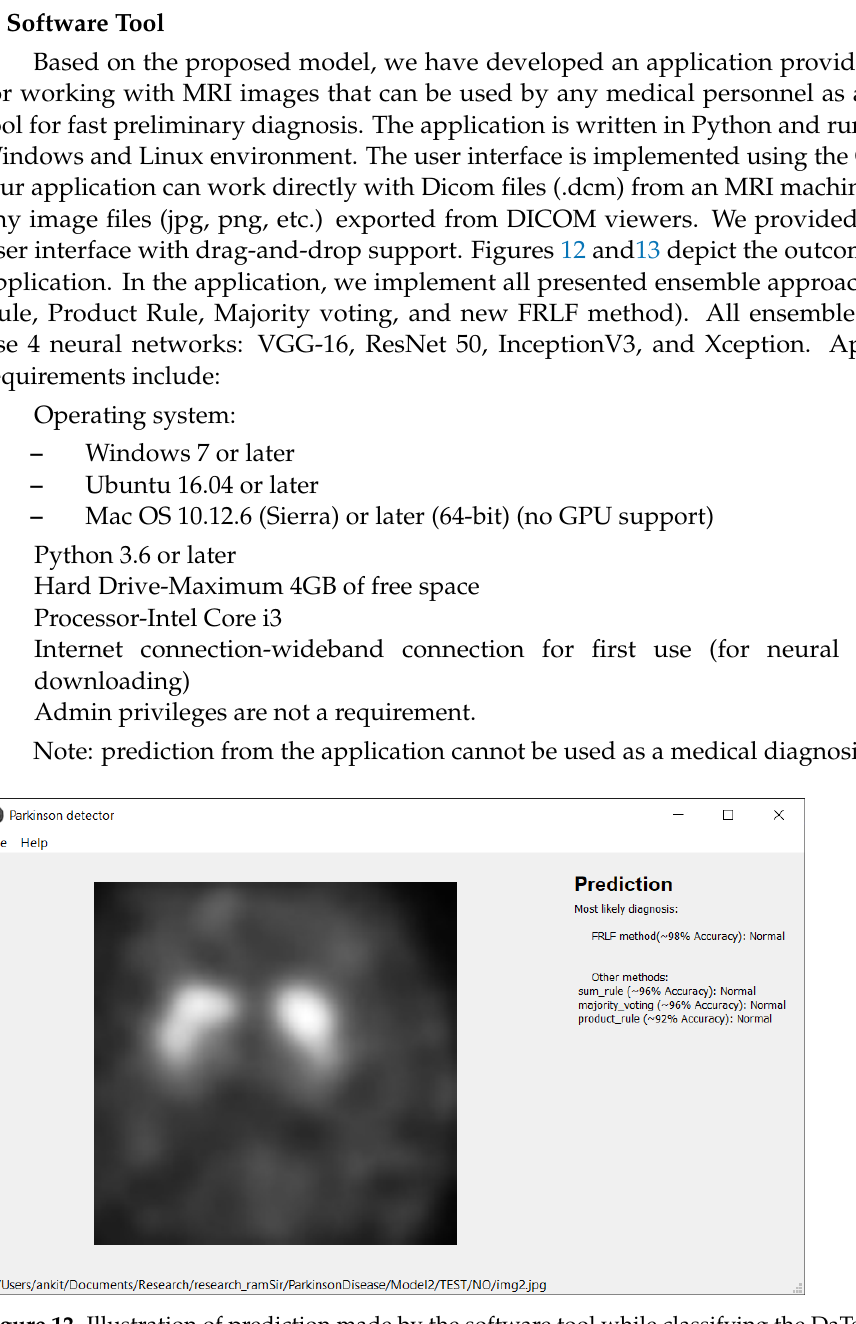
Figure 12. Illustration of prediction made by the software tool while classifying the DaTscan image as “Normal”